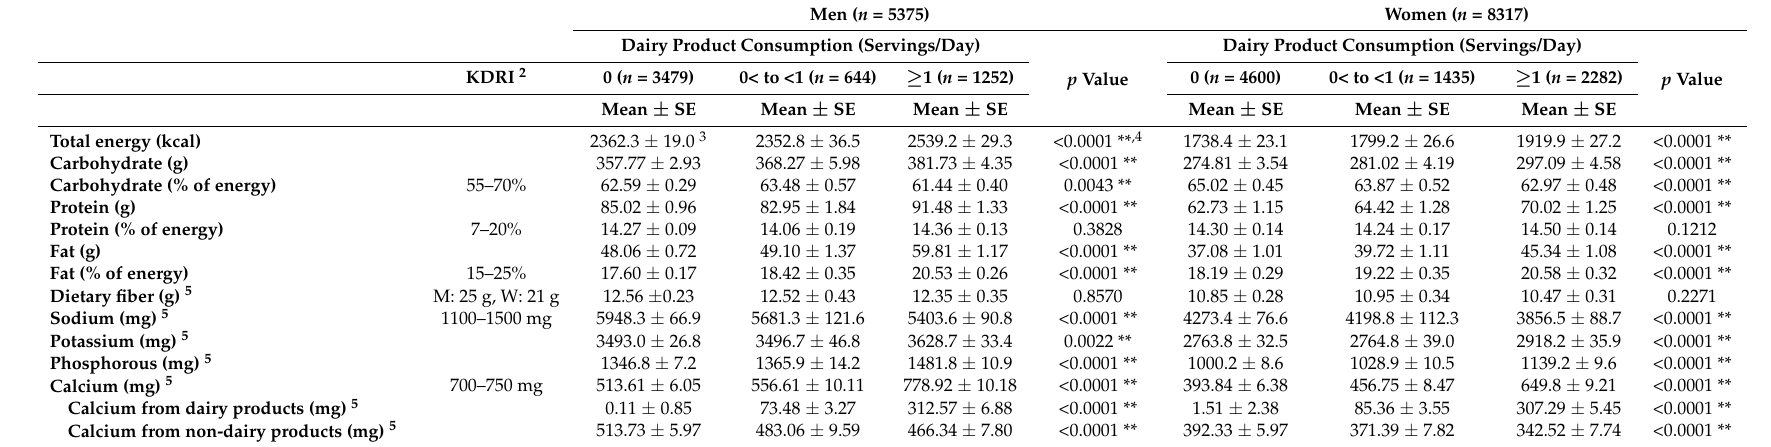
Table 2. Energy and nutrient intakes by dairy product consumption in Korean adults, KNHANES 2010–2013 1